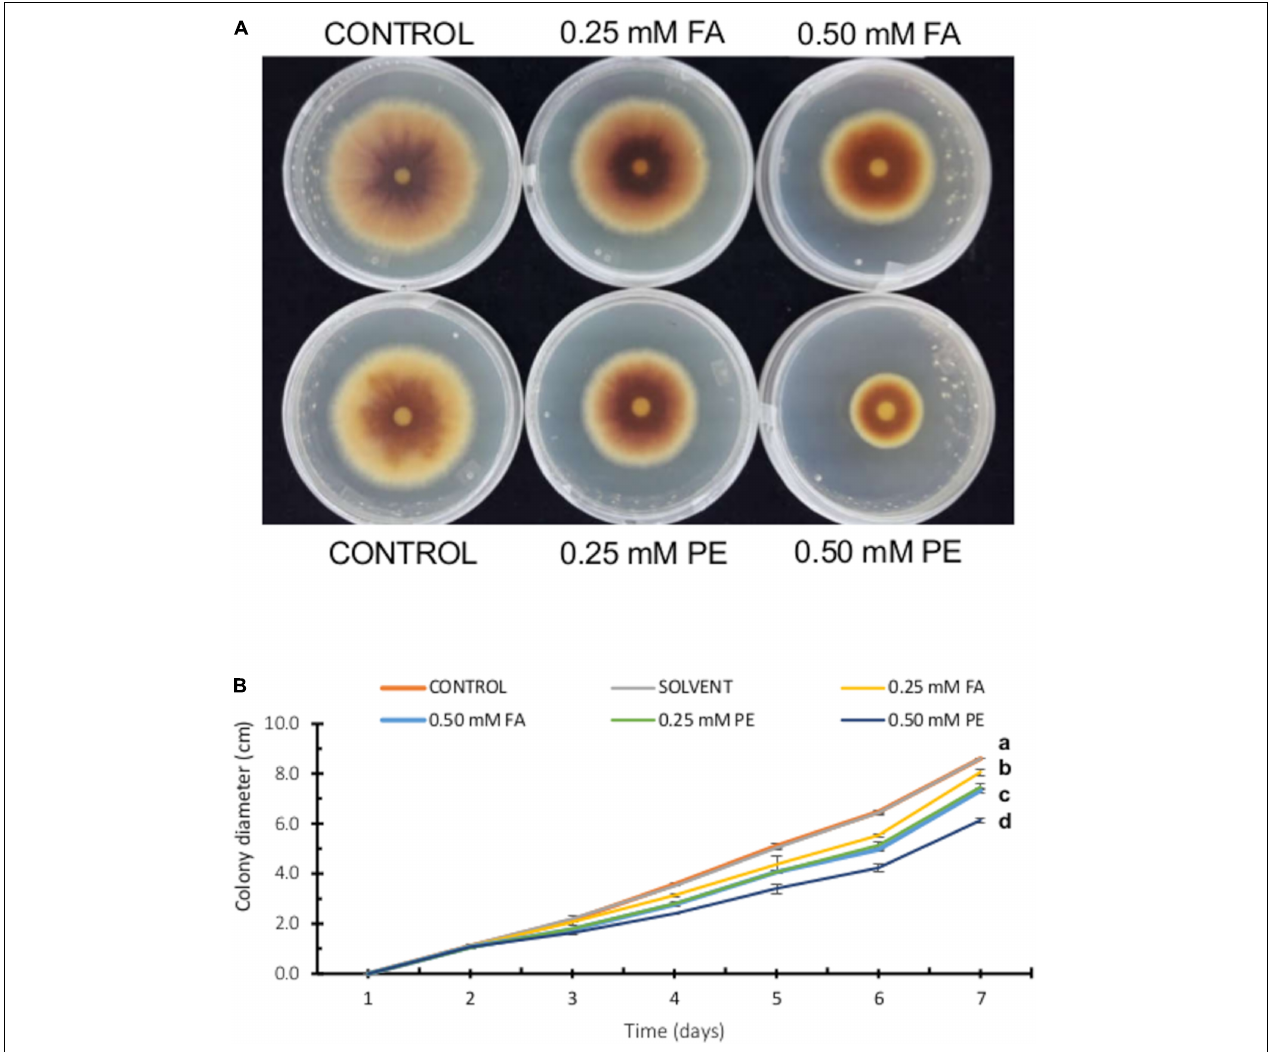
FIGURE 4 | Effect of ferulic acid and pericarp extracts (PE) on F. verticillioides radial growth. (A) Representative images of F. verticillioides growing on PDA plates containing FA (0.25 or 0.50 mM) and pericarp extracts containing the equivalent concentrations of FA. (B) Colony diameter of F. verticillioides (5 × 10 3 conidia inoculum) growing on PDA plates containing FA (0.25 or 0.50 mM) and pericarp extracts containing the equivalent concentrations of FA. Values are means ± SD, and different lowercase letters indicate significant differences, as analyzed by ANOVA followed by Tukey’s comparison test ( n = 3; p <